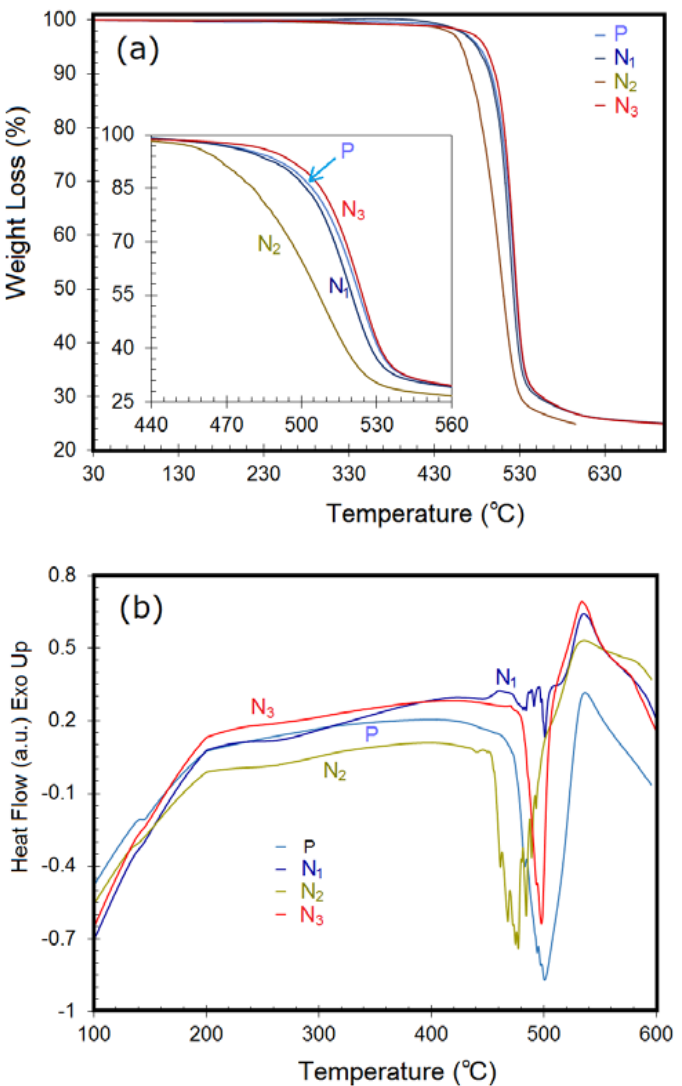
Figure 6. Thermographic analysis of PC and different PC/TiO 2 composites: ( a ) Overall thermogravi- metric curves with inset differentiating the onset of thermal decomposition; ( b ) DSC thermograms indicating T g values. The samples P, N 1 , N 2, and N 3 represent PC, PC/TiO 2 -0.5NP, PC/TiO 2 -0.1NW, and PC/TiO 2 -0.05HN, respectively. Table 2. Temperatures corresponding to different weight losses from TGA results and DSC data for the as-received PC and different PC/TiO 2 composites.